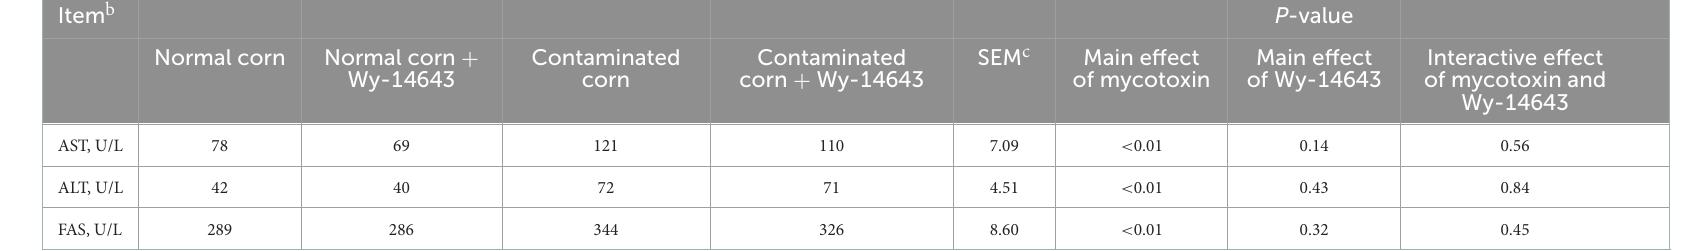
TABLE 7 Effects of PPAR- α agonist on enzyme concerned with lipid metabolism in broilers fed mycotoxin contaminated corn a . Item